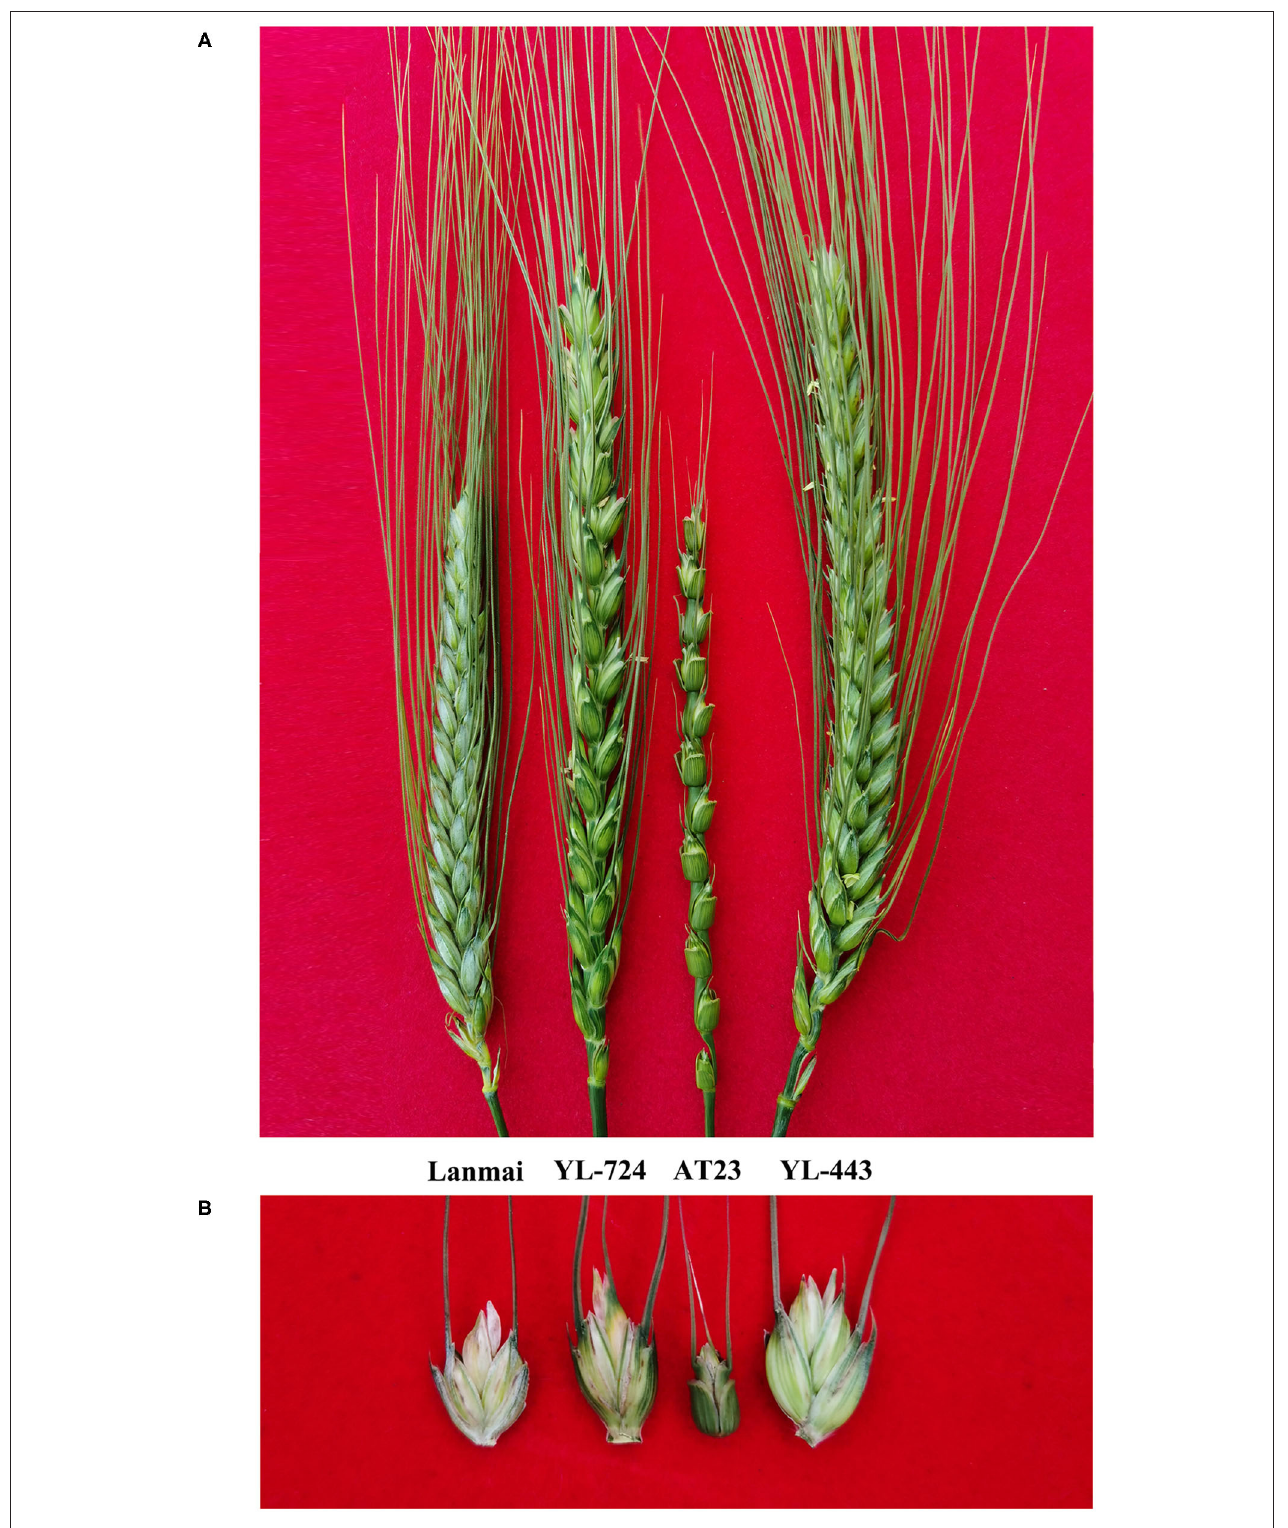
FIGURE 4 | The spike and spikelet comparison of durum wheat Lanmai, Lanmai/AT23 amphiploid line YL-724, Ae. tauschii AT23, and Lanmai 4D(4B) disomic substitution line YL-443. (A) Spike comparison. (B) Spikelet comparison.